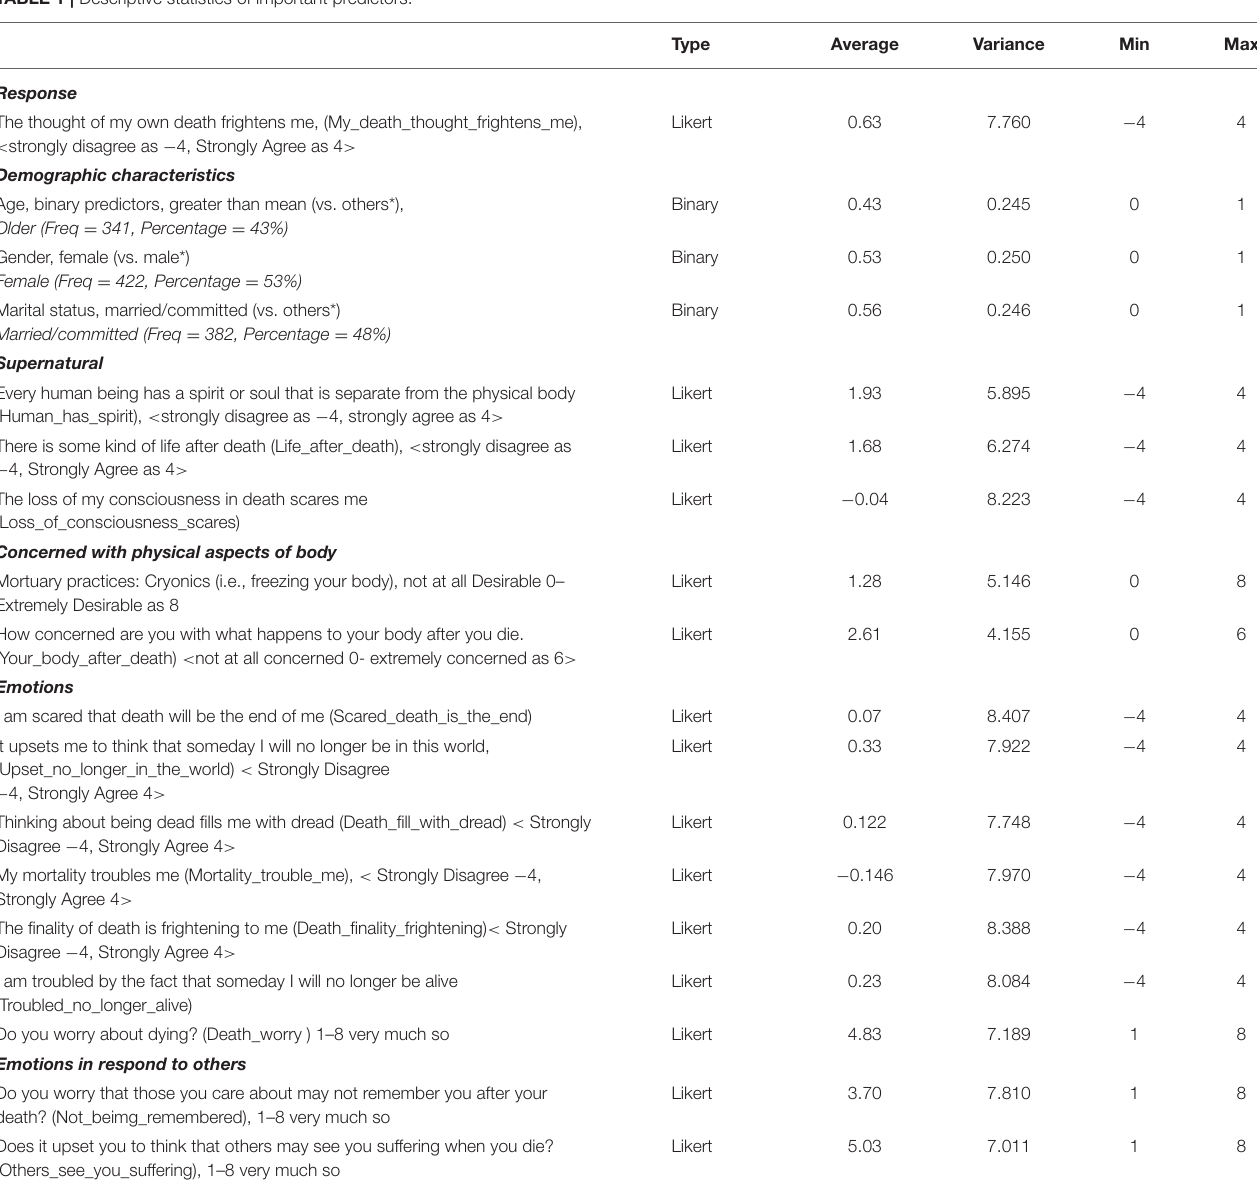
Type Average Variance Min Max